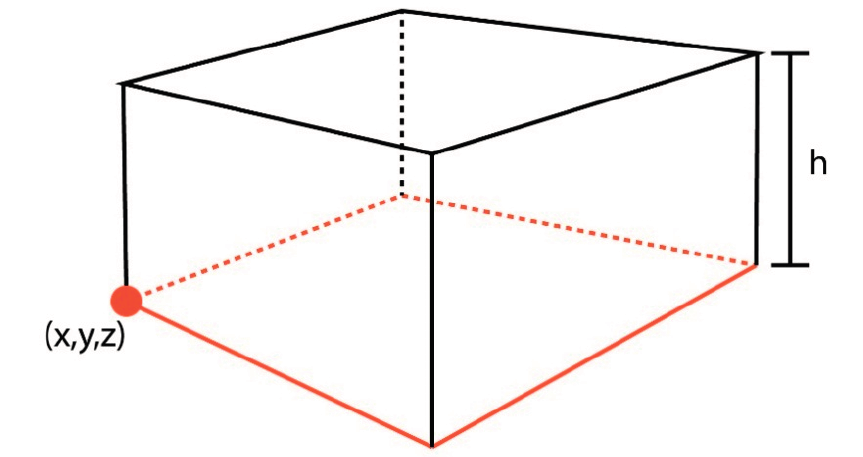
Figure 2. Single building model, with the original outline marked in orange, showing the height (h) and the origin (x,y,z) of the mesh model coordinate